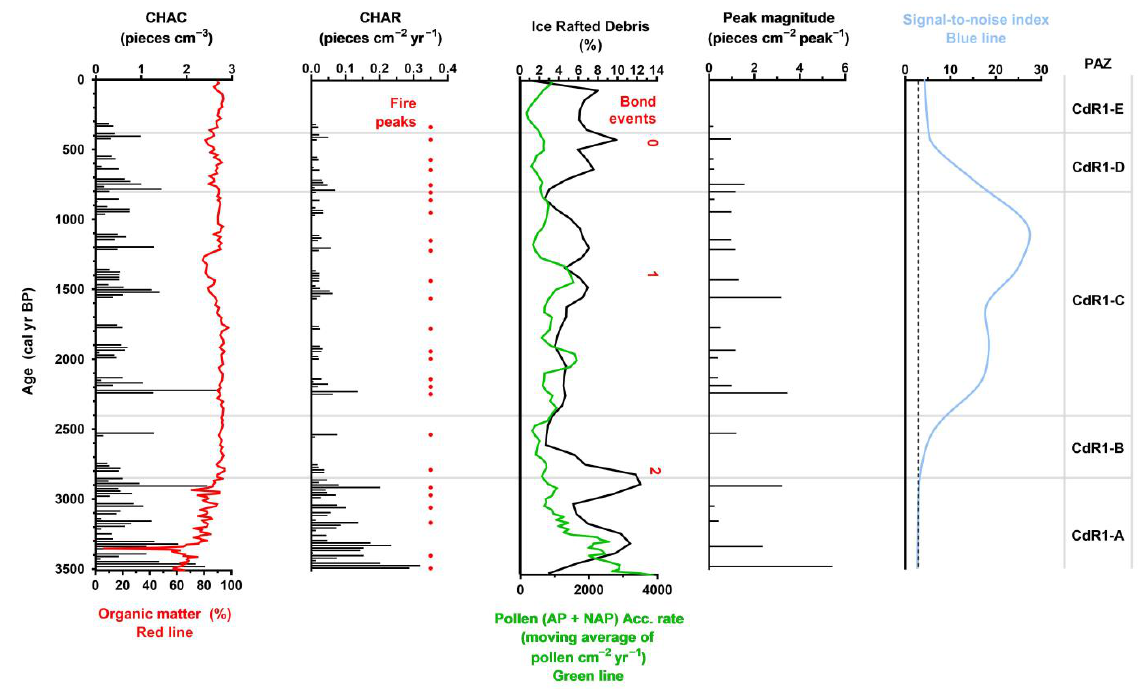
Figure 6. Sedimentary charcoals (>150 µm) (CHAC: charcoal concentration; CHAR: charcoal accumulation rate; fire peaks; peak magnitude; signal-to-noise index), organic matter, and pollen (arboreal and non-arboreal) accumulation rate. The Ice Rafted Debris (IRD) index (stack of MC52-V29191 + MC21-GGC22 [13]) is shown for comparison with the CdR1 record. The cutoff value of the signal-to-noise index = 3 [57] is indicated as a black dashed line. Pollen assemblage zones (PAZ) are also shown.